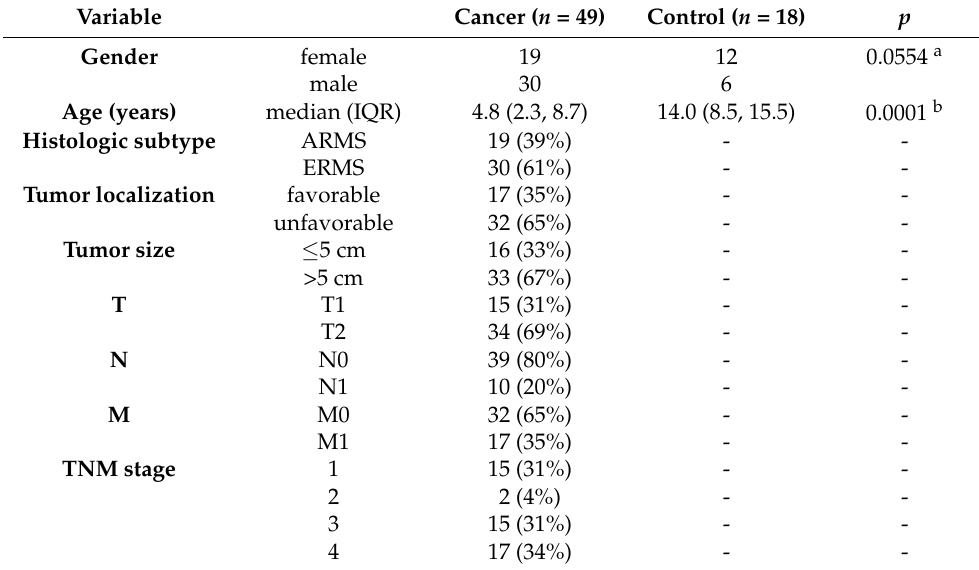
Table 1. Baseline patients’